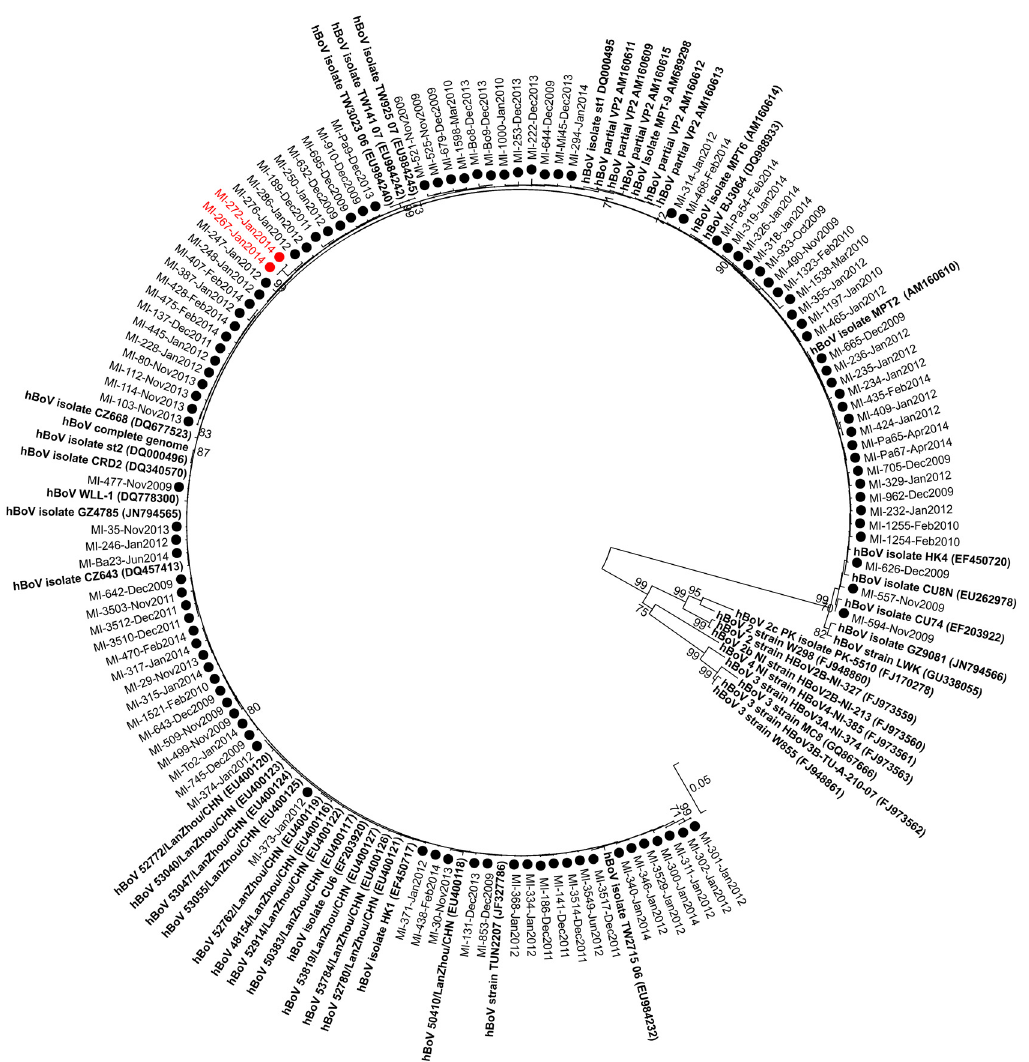
Fig 1. Phylogenetic tree based on complete VP1/VP2 gene sequences of human bocavirus (hBoV) strains. Sequences originating from this study are indicated with black and red circles. HBoV reference stains are in bold. The percentage of replicate trees in which the associated taxa clustered together in the bootstrap test (1,000 replicates) are shown next to the